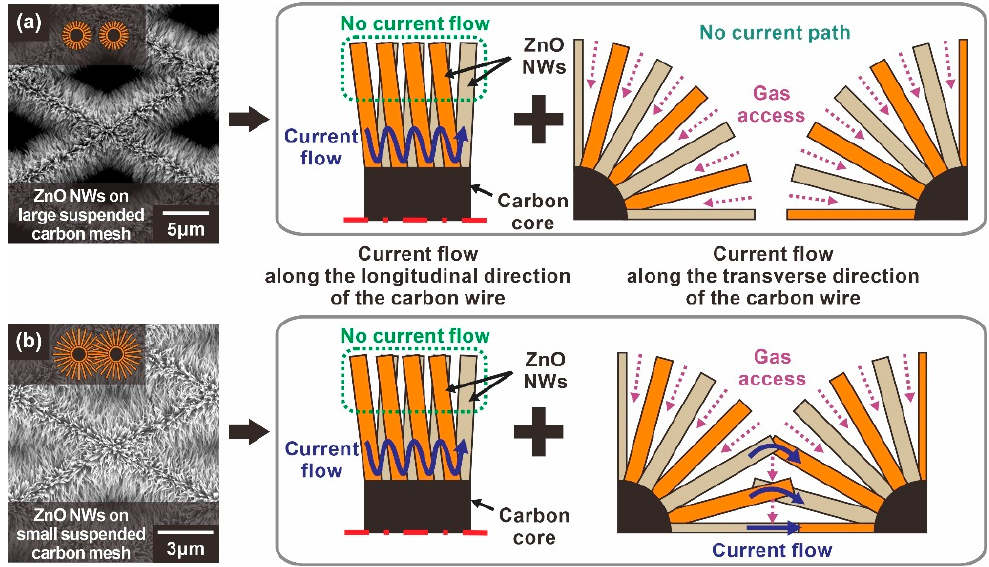
Figure 4. Schematic illustration of the current path of suspended ZnO NW networks according to the void size of the carbon mesh: ( a ) Type A: ZnO NWs grown on a suspended carbon nanomesh with voids too large to form longitudinally connected junctions, ( b ) Type B: ZnO NWs grown on a suspended carbon nanomesh with voids small enough to form longitudinally connected junctions.